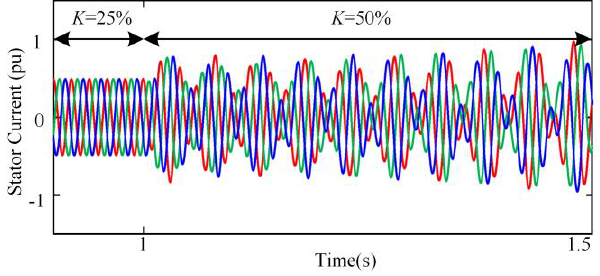
Figure 9. Waveform of stator currents, at the 50% series-compensation level.